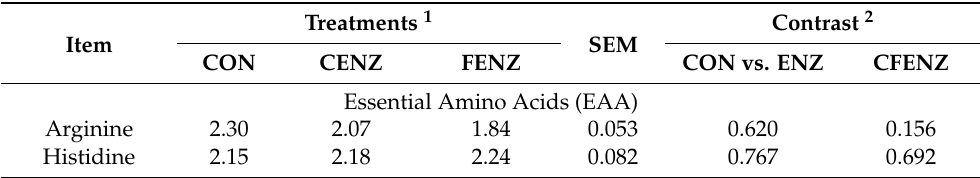
Table 4. Milk amino acids composition (g/100 g of milk protein) of dairy buffaloes as affected by cellulase enzyme supplementation to the